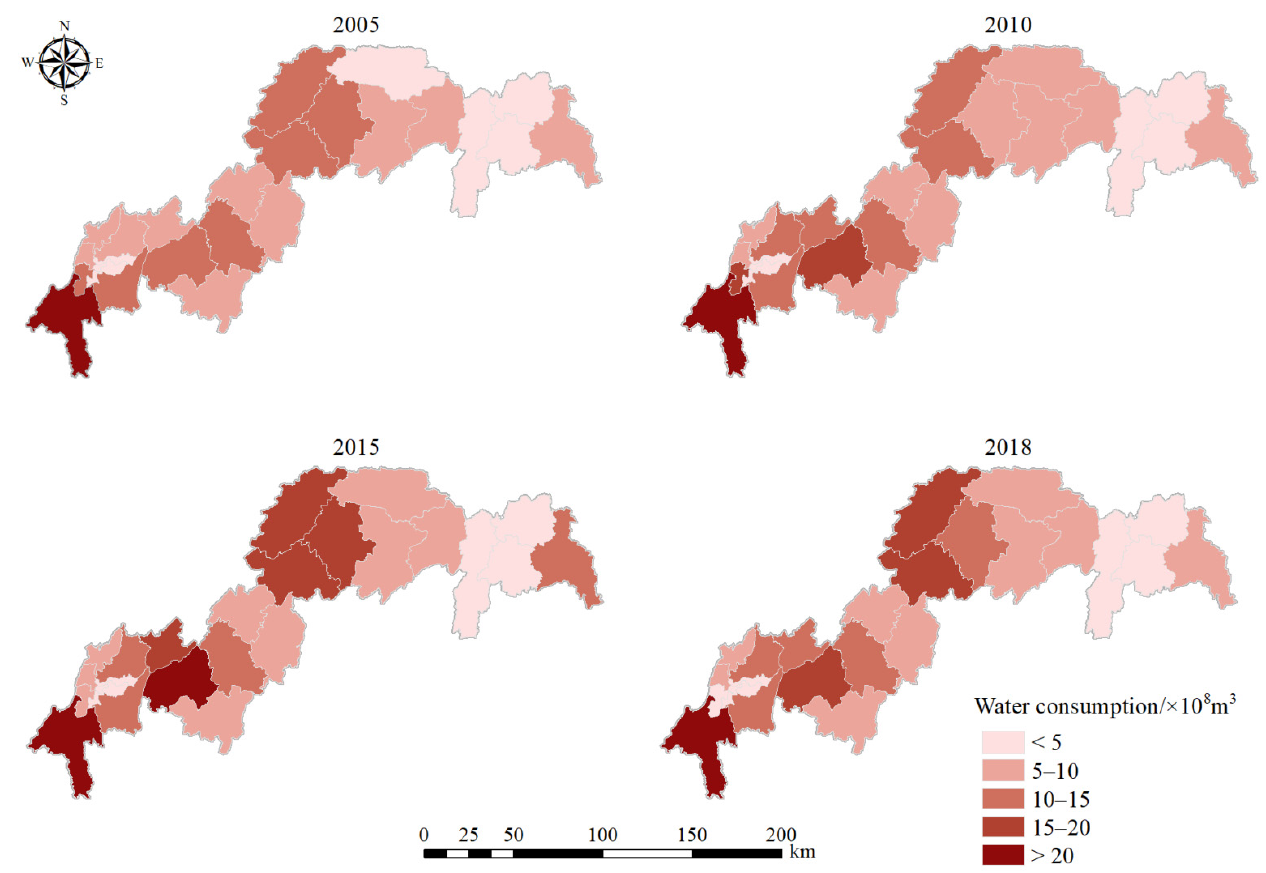
Figure 10. Spatiotemporal distribution of water consumption in the Three Gorges Reservoir Area from 2005 to 2018.